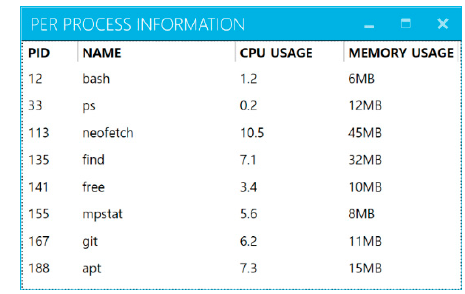
Figure 11. Per-process informati on of the GUI c lient.